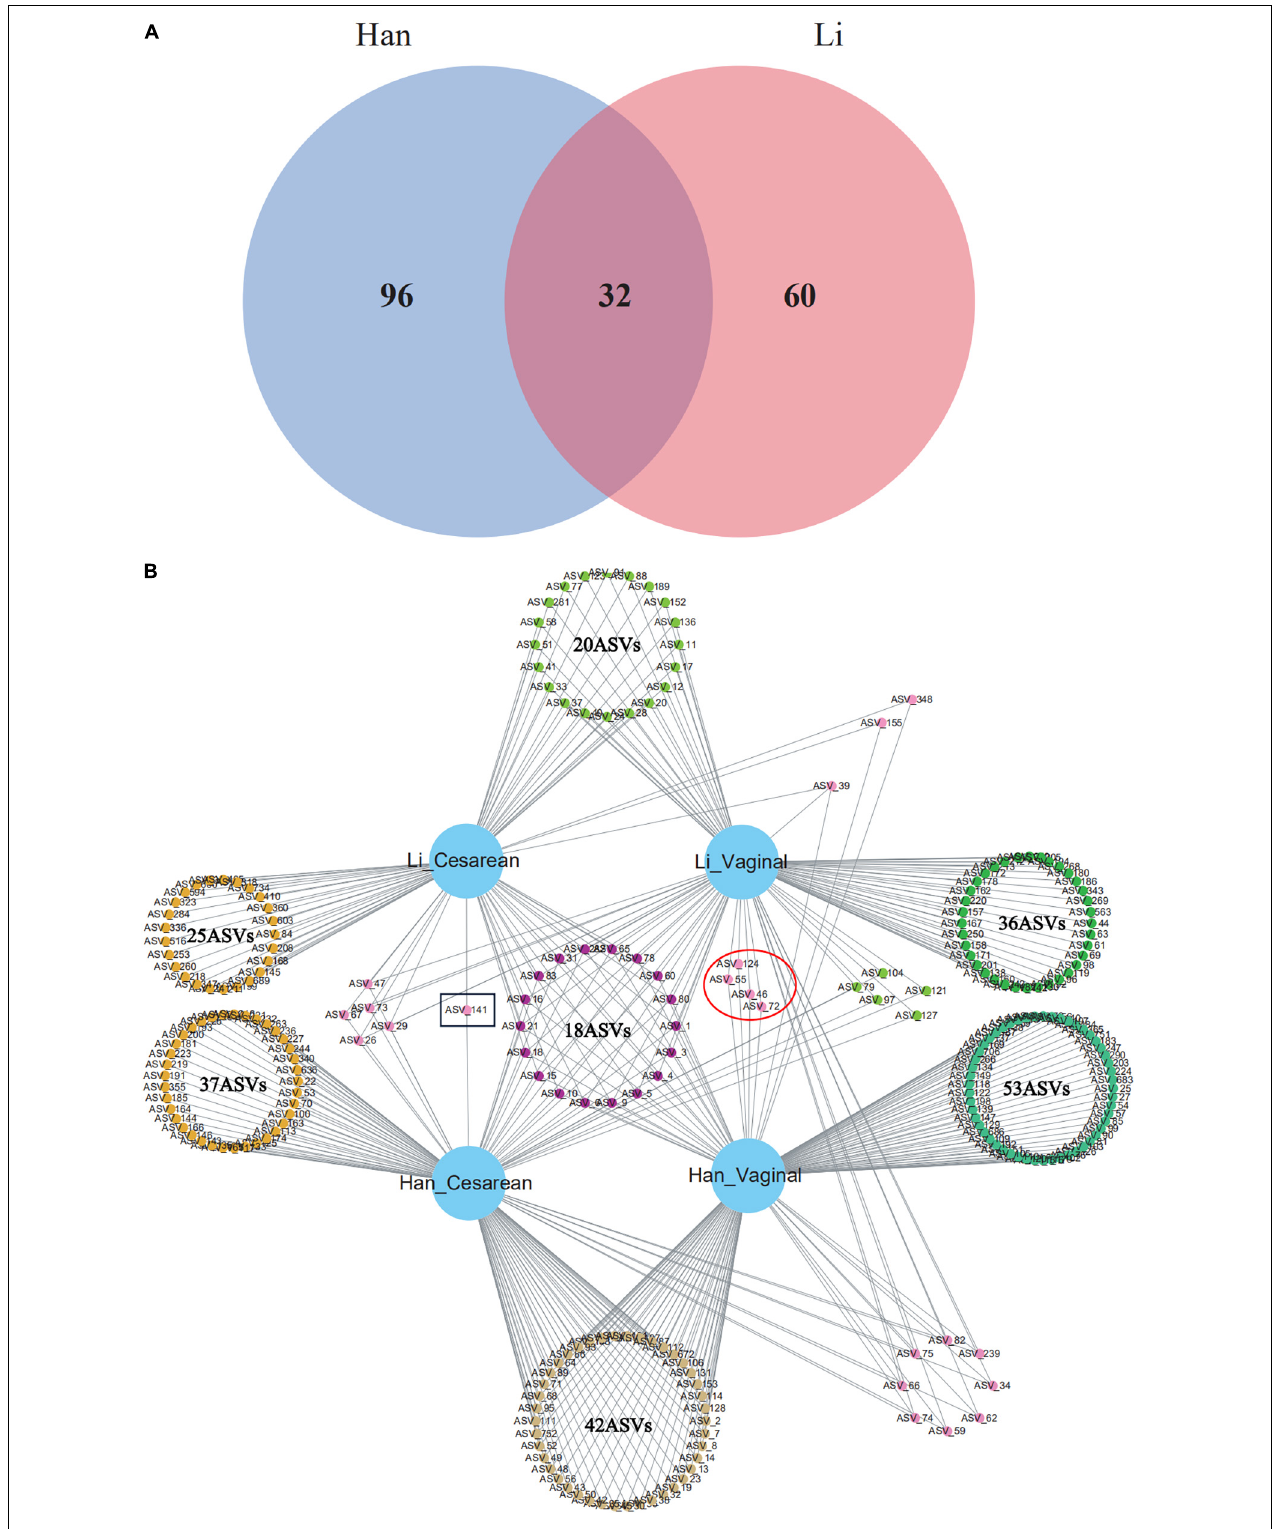
FIGURE 3 | Venn diagram of core ASVs (or known bacterial species) sharing among (A) Han and Li ethnic groups or (B) ethnic and delivery mode groups (Li_Vaginal and Li_Cesarean and Han_Vaginal and Han_Cesarean).